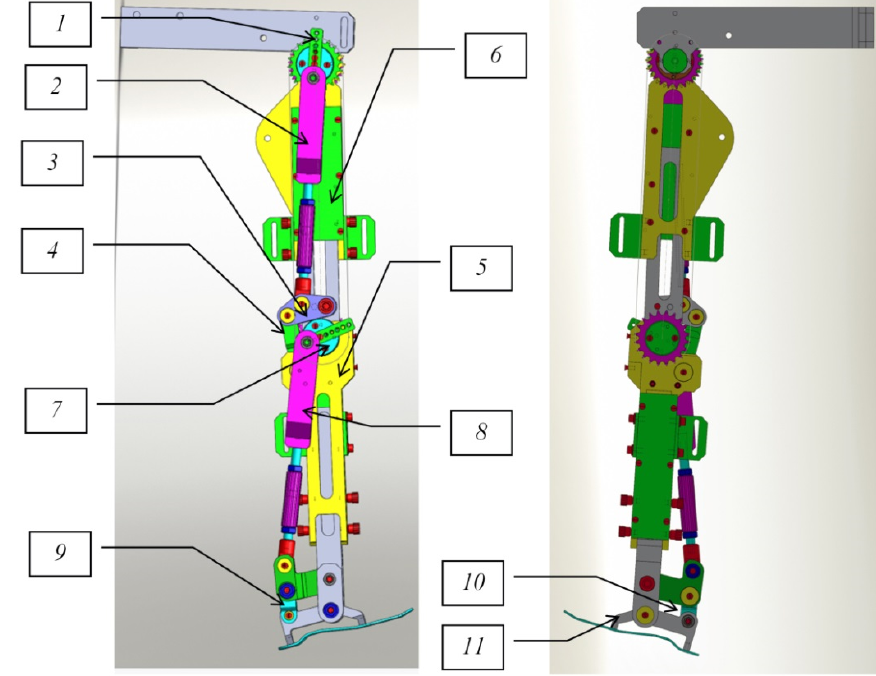
Figure 17. Left leg exoskeleton virtual model.